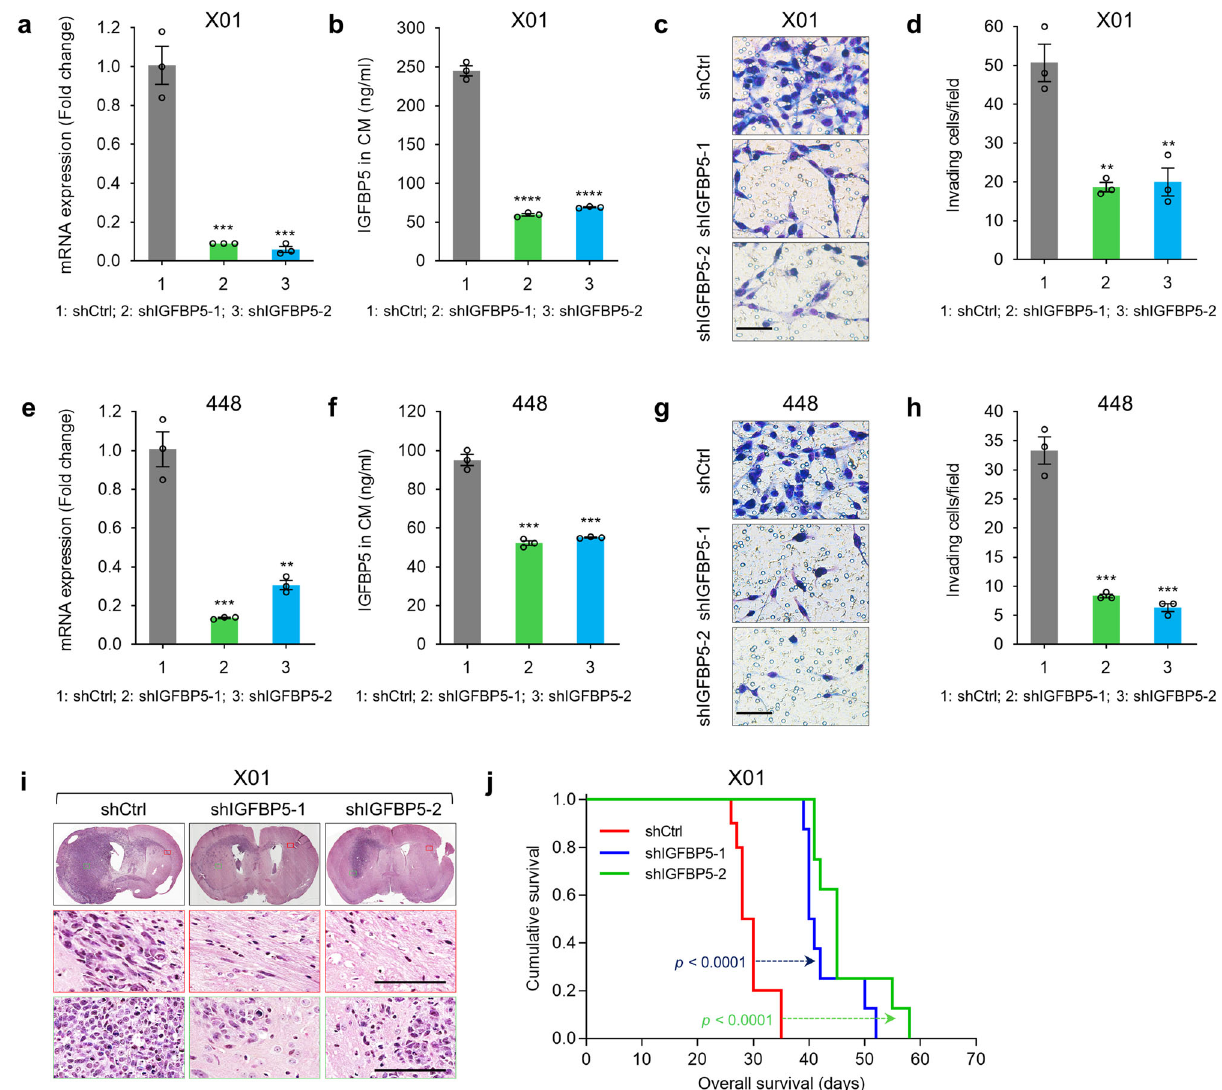
Fig. 2 | Inhibition of IGFBP5 impairs GSCs invasion and tumorigenesis. a RT-qPCRanalysisofIGFBP5mRNAexpressioninX01GSCsinfectedwithlentivirus expressing shIGFBP5 or shCtrl. Data are presented as mean±SEM ( n =3 indepen- dent experiments), two-tailed Student ’ s t- test (left to right, *** P =0.0008, *** P =0.0007). b ELISAanalysisofIGFBP5inCMfromX01GSCsinfectedwithshCtrl, shIGFBP5-1, or shIGFBP5-2 lentivirus. Data are presented as mean±SEM ( n =3 independent experiments), two-tailed Student ’ s t- test (left to right, **** P =0.00001, **** P =0.00001). c , d InvasionassayswithX01GSCsinfectedwithshCtrl,shIGFBP5-1, orshIGFBP5-2lentivirus. c Imagestakenafter48hofinvasionarerepresentativeof three independent experiments (scale bar, 100 μ m; n =3), and d the graph shows the mean number of invasive cells ± SEM, two-tailed Student ’ s t -test (left to right, ** P =0.003, ** P =0.007). e RT-qPCR analysis of IGFBP5 mRNA expression in 448 GSCs infected with shCtrl, shIGFBP5-1, and shIGFBP5-2 lentivirus. Data are pre- sented as mean±SEM ( n =3 independent experiments), two-tailed Student ’ s t- test